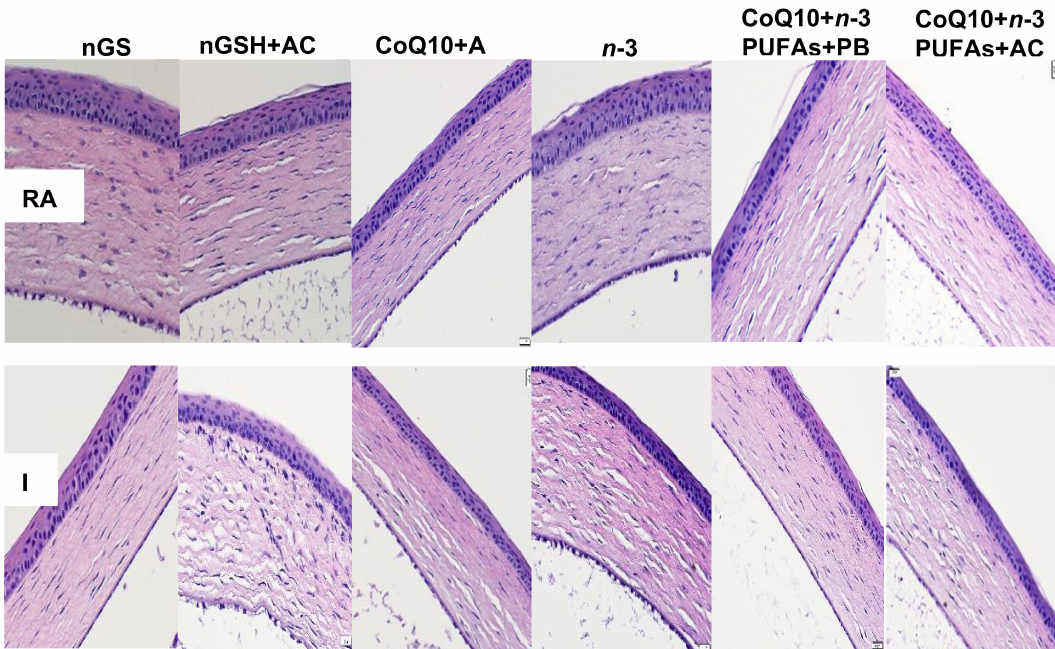
Figure 6. Representative H&E stained corneas from neonatal rats on postnatal day 21 (P21). Room air (RA) groups are represented in the top panels and intermittent hypoxia (IH) groups are represented in the bottom panels. Images are 40 × magnification, scale bar is 20 µ